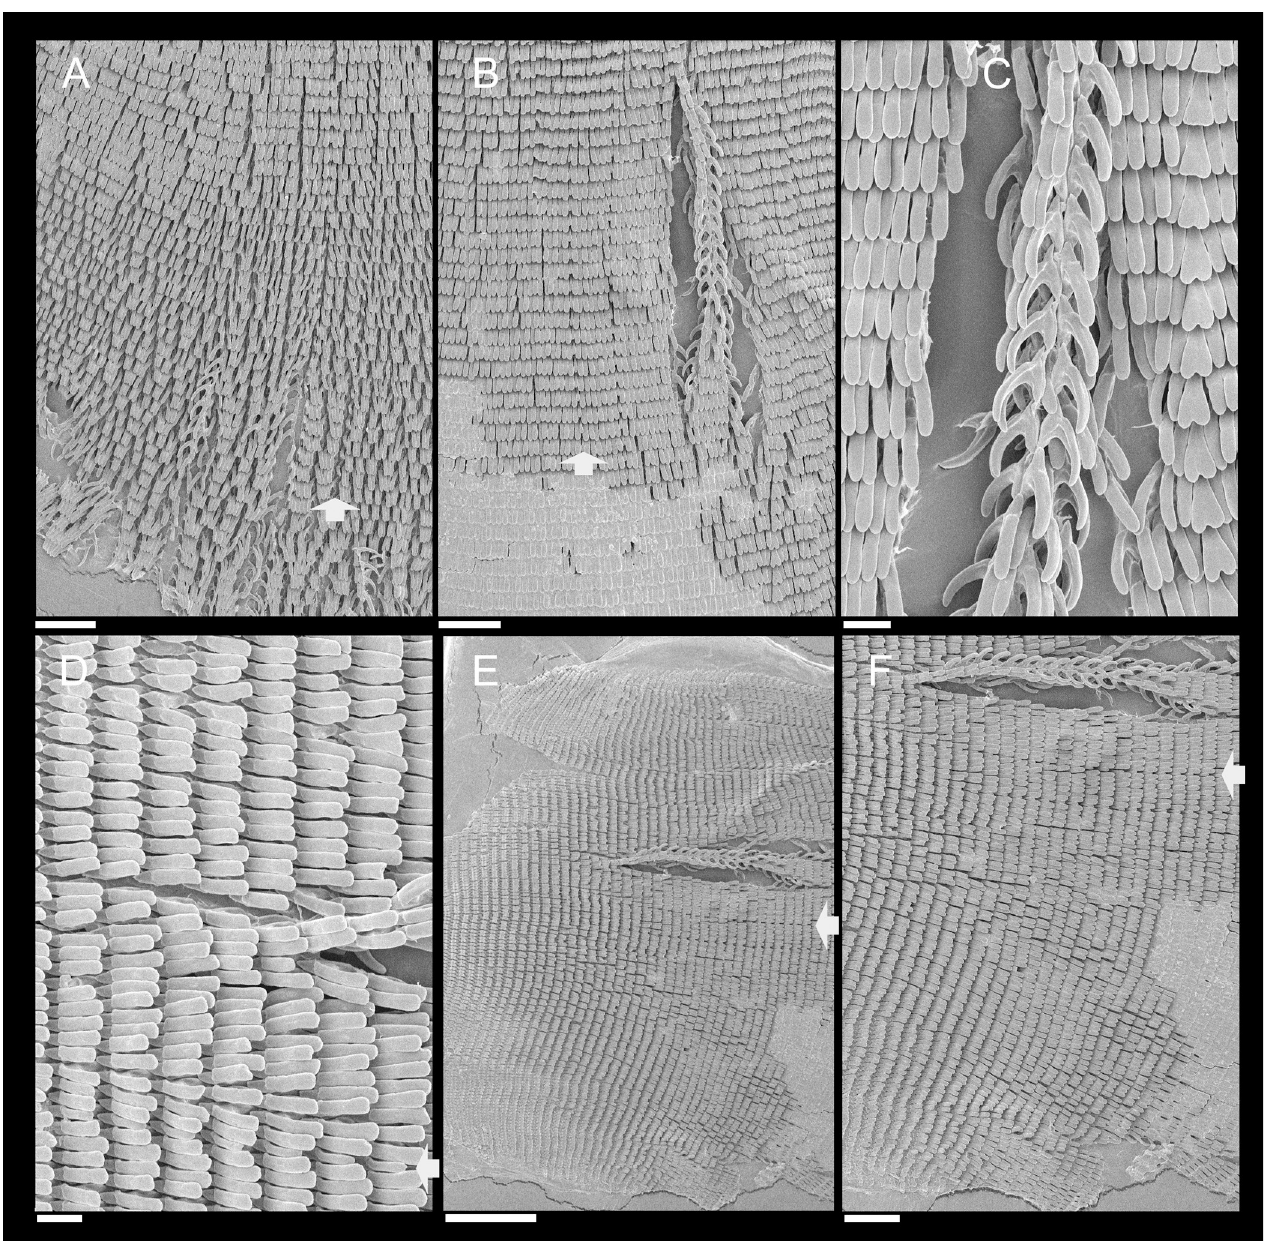
Fig 15. Anthinus morenus , Radula in SEM, paratype MZSP 152047. (A) wide view, scale = 200 μ m; (B) detail of central region, scale = 200 μ m; (C) detail of damaged region, with teeth in profile, scale = 50 μ m; (D) detail of right region, scale = 50 μ m; (E) wide view, scale = 500 μ m; (F) detail of left region, scale = 200 μ m. White arrows indicating rachidian